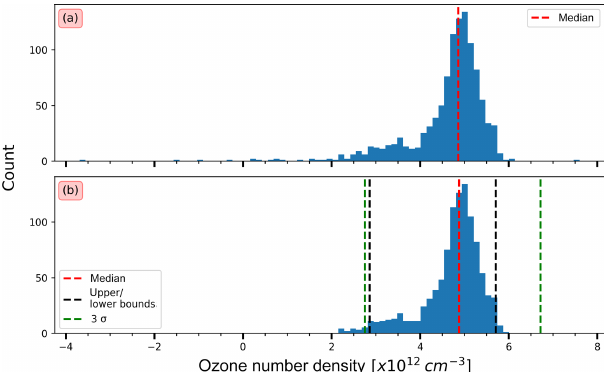
Figure 12. As in Fig. 10 but for ozone data at 20km between 65 and 75 ◦ S in